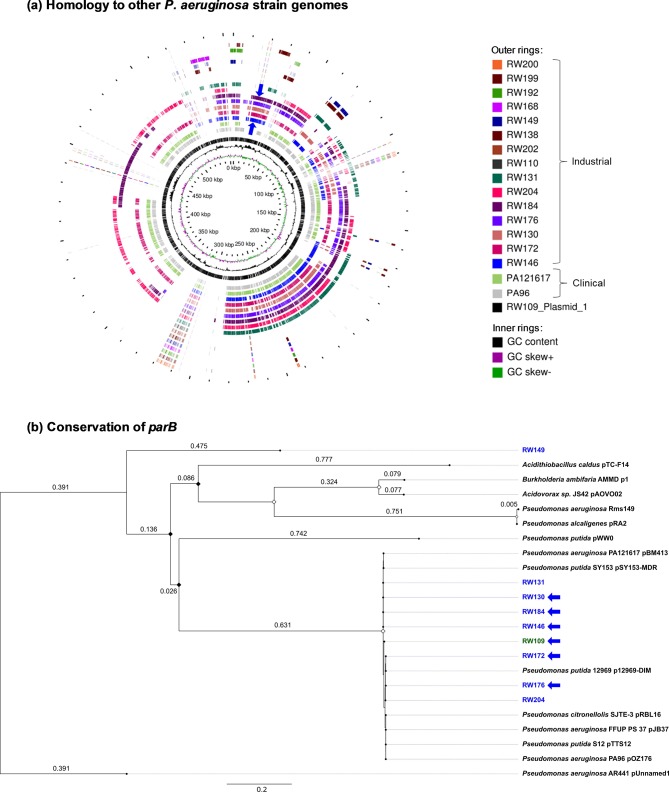
Homology of the RW109 megaplasmid and its conservation among extremely stress-tolerant
Pseudomonas
 strains. (a) The CGView Comparison Tool [38] was used to map the
P. aeruginosa
 industrial strain sequences, along with the clinical strains PA121617 and PA96, to a circular map of the RW109 megaplasmid. Prokka-generated GenBank files were used as an input and were converted into CGView XML files for generation of the genome circular comparison map. The colour-coded key shows regions of each strain with homology to the megaplasmid, with their source indicated by the parentheses. The blue arrows indicate the approximate location of the conserved BpeEF-OprC efflux pump present in the industrial strains. (b) A maximum-likelihood phylogenetic tree of the RW019 megaplasmid parB gene (green text) aligned against homologous sequences from the
P. aeruginosa
 industrial strains (blue text) and other related
Pseudomonas
 plasmids. Industrial strains uniquely encoding components of the BpeEF-OprC efflux pump are indicated by the blue arrows. Bootstrap values are indicated at the node (diamonds; white nodes ≥75 % and black nodes ≤75 %) and the genetic distance (the number of base substitutions per site) is indicated on the branches and by the scale bar. The tree was rooted with the parB gene from an unnamed plasmid in
P. aeruginosa
 strain AR441.